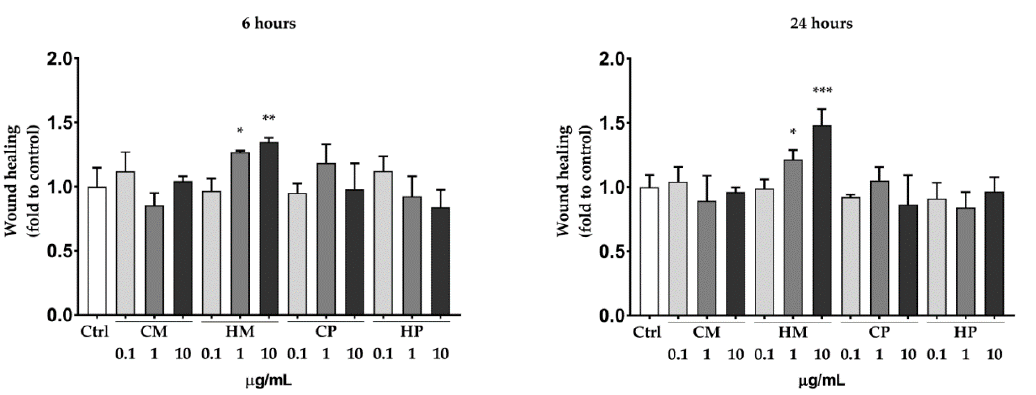
Figure 2. Scratch wound healing assay. The assay was performed 6 ( left ) and 24 ( right ) hours after treating HaCaT cells with increasing concentrations (0.1 to 10 μg/mL) of different extract (as indicated) or DMSO (Ctrl). Data are expressed as mean ± SD of three independent experiments and normalized to the Ctrl value * p < 0.05 vs. control; ** p < 0.01 vs. control; *** p < 0.001 vs. control by one-way ANOVA.